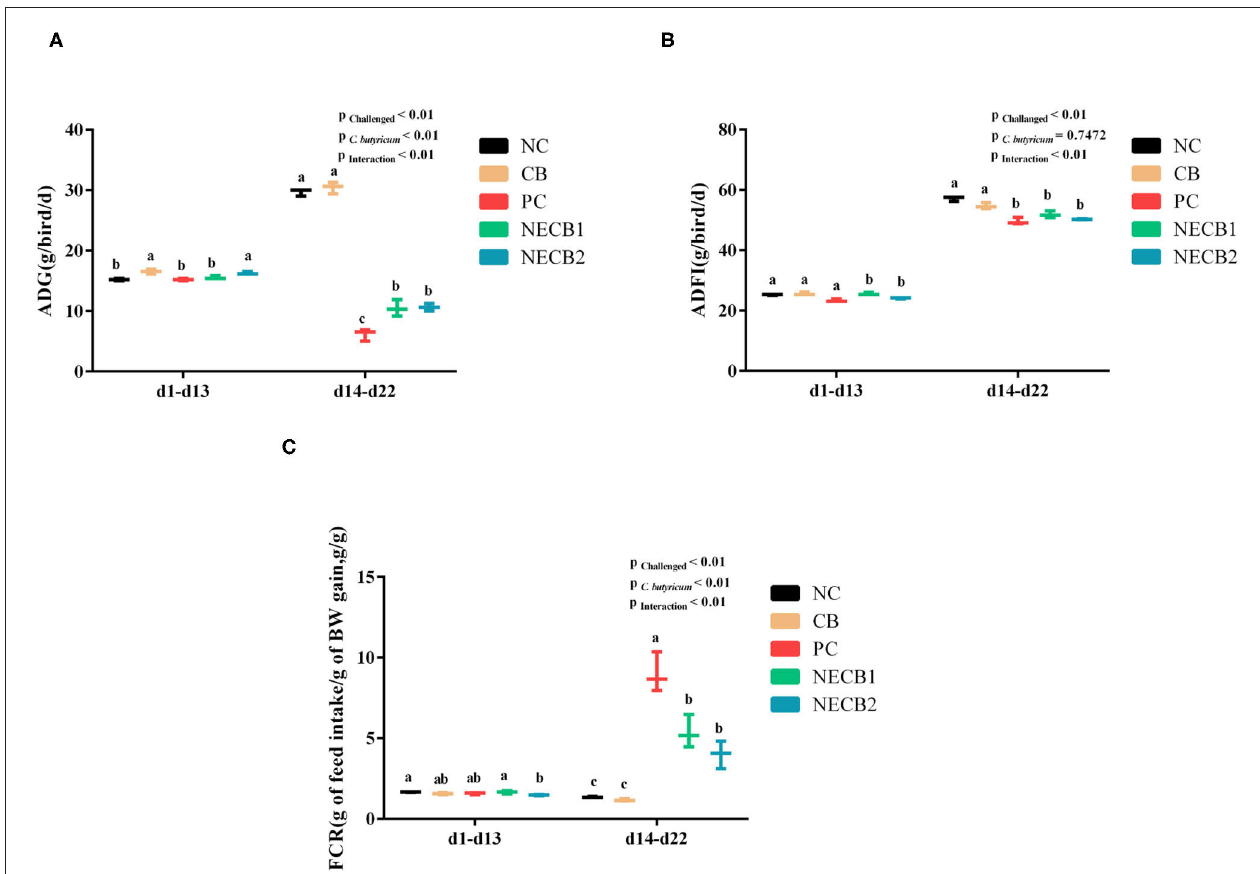
FIGURE 1 | Effect of diet Clostridium butyricum supplementation on ADG, ADFI, and FCR of broilers infected with necrotic enteritis. (A) ADG: average daily weight gain. (B) ADFI: average daily feed intake. (C) FCR: feed conversion rate. Each result represents the mean ± SEM ( n = 3). The different lowercase letters on the figure indicate significant differences ( p <